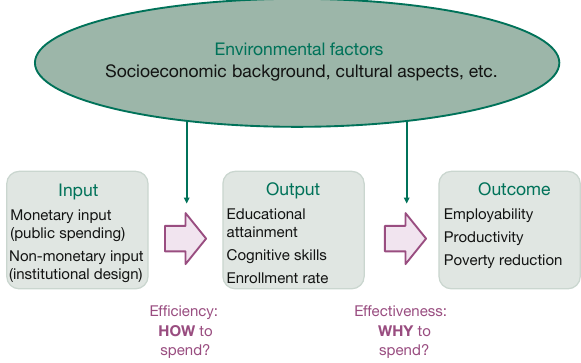
Figure 2 Framework for analysing the effi ciency of public spending on